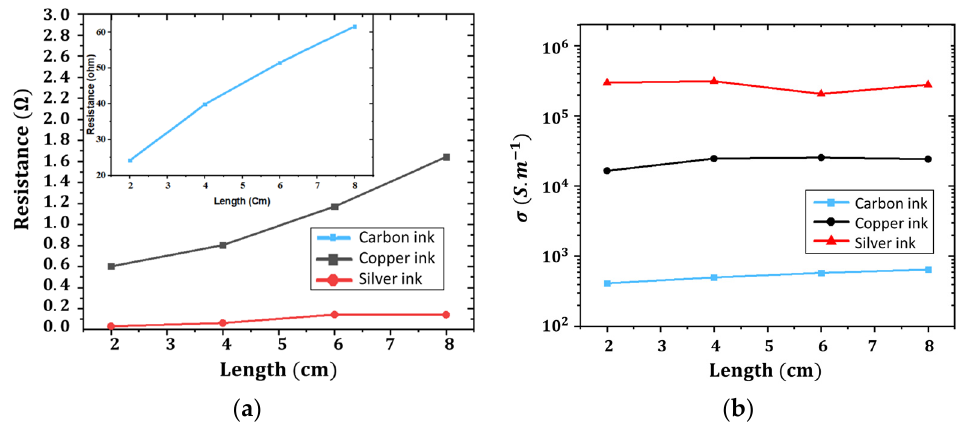
Figure 14. Evolution of the electrical property as a function of the length of different conductive inks: ( a ) electrical resistance and ( b ) electrical conductivity.